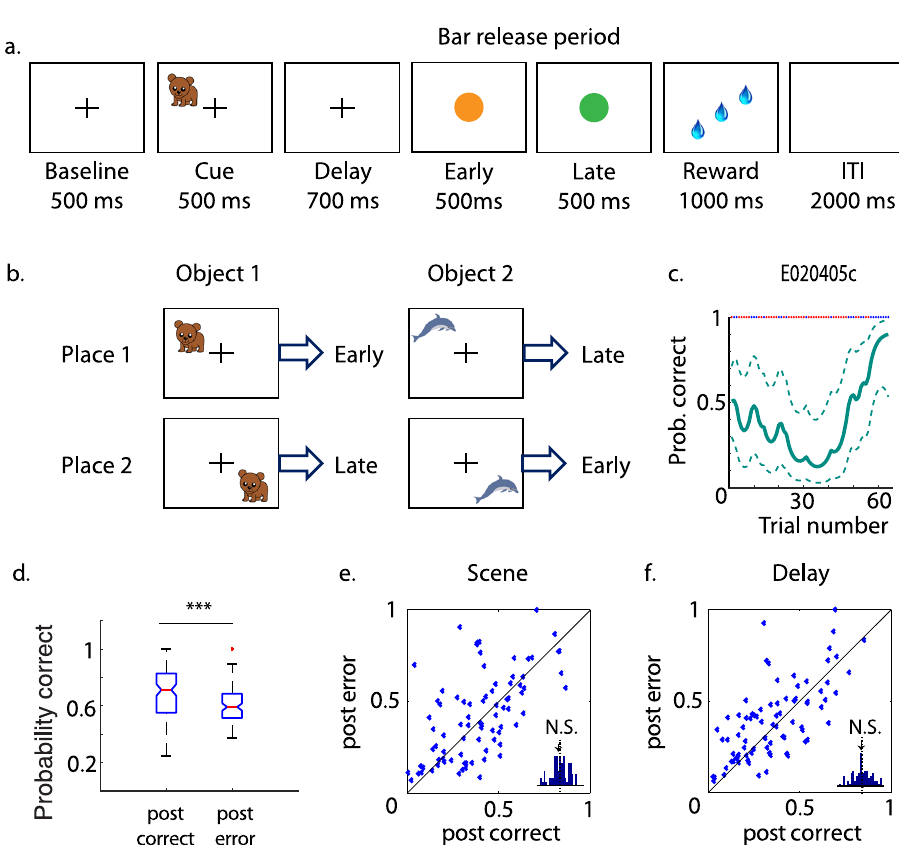
Fig. 3 Object-place task (OPT), performance, and selectivity index (SI). a Schematic illustration of the OPT. b Illustration of the object-place response contingencies used each day. c Estimated performance of one example OPT session. The red dots at the top of the graph indicate error trials and the blue dots indicate correct trials. The dashed lines indicate the 95% con fi dence intervals. d The averaged performance immediately after correct trials (0.7 ± 0.017) is signi fi cantly better than after error trials (0.61 ± 0.01) for the OPT (*** p < 0.001, t -test. The labels of the boxplots are the same as in Fig. 1c. Individual data points are shown in Supplementary Fig. 7b). The SI immediately after error trials is not signi fi cantly different from after correct trials during either the scene ( e ) or delay ( f ) period of the task. All data points are shown in Supplementary Data